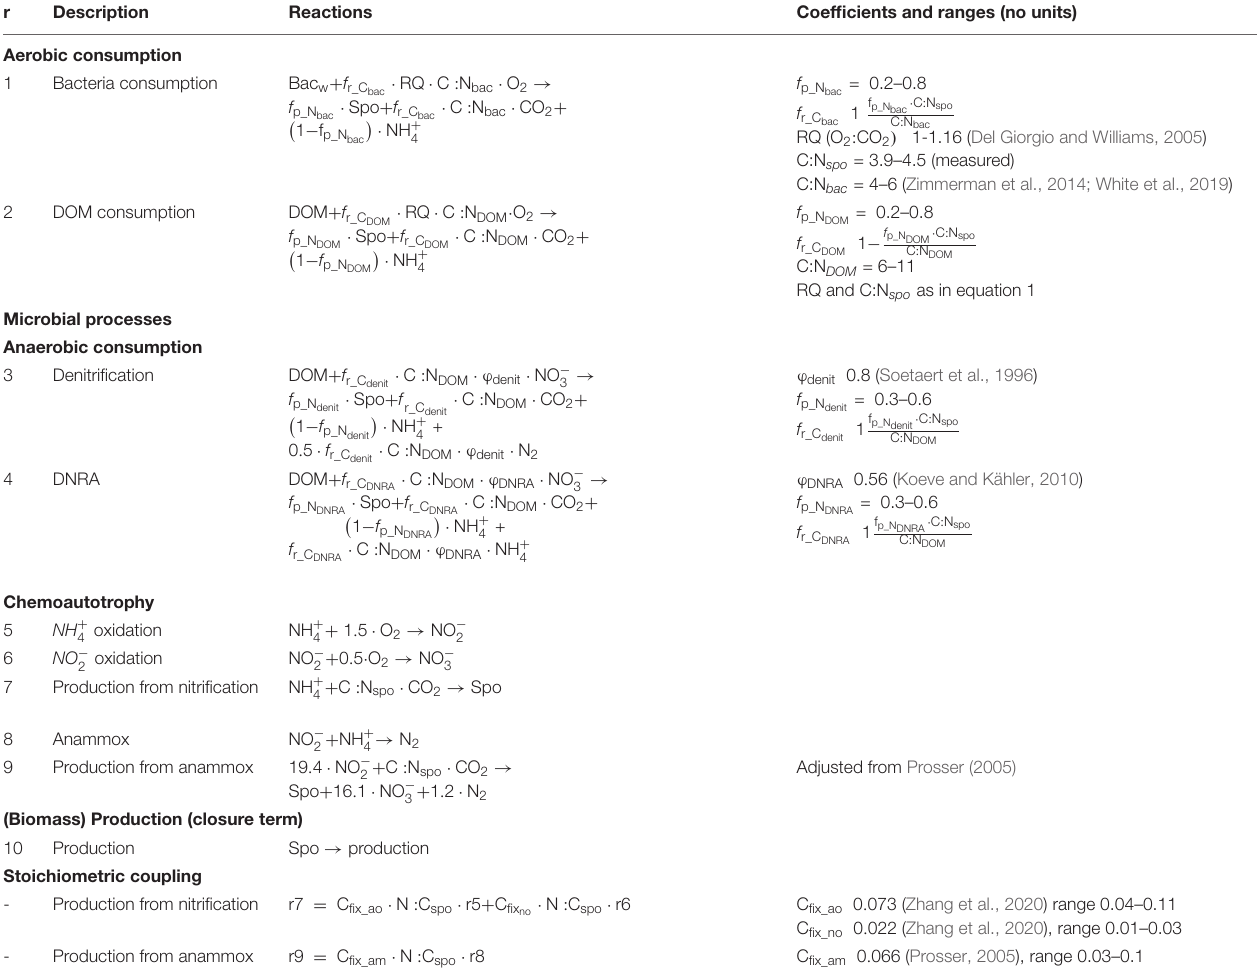
TABLE 2 | Reactions and coefficients involved in C, N, and O metabolism as implemented in the metabolic network model. r Description Reactions Coefficients and ranges (no